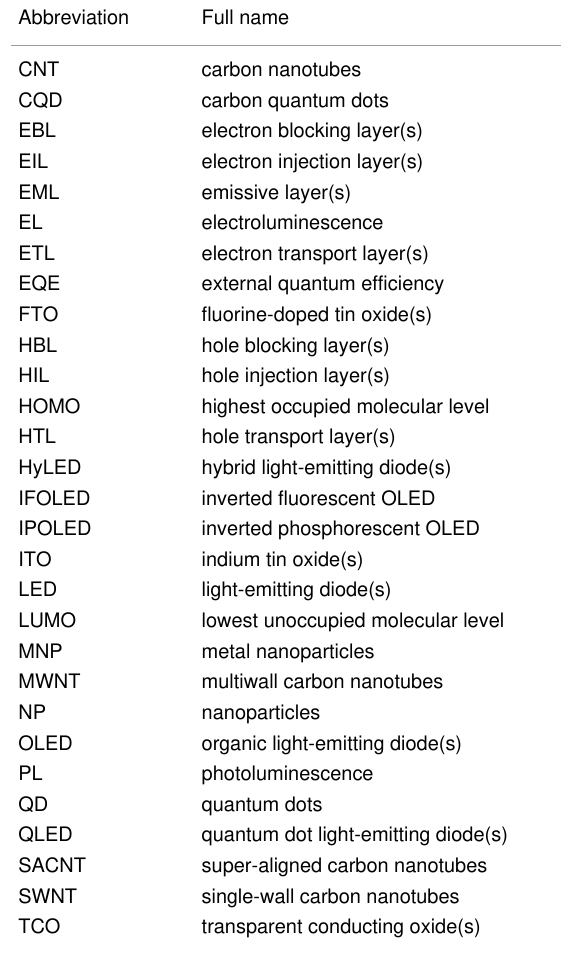
Table 1: List of abbreviations mentioned in this